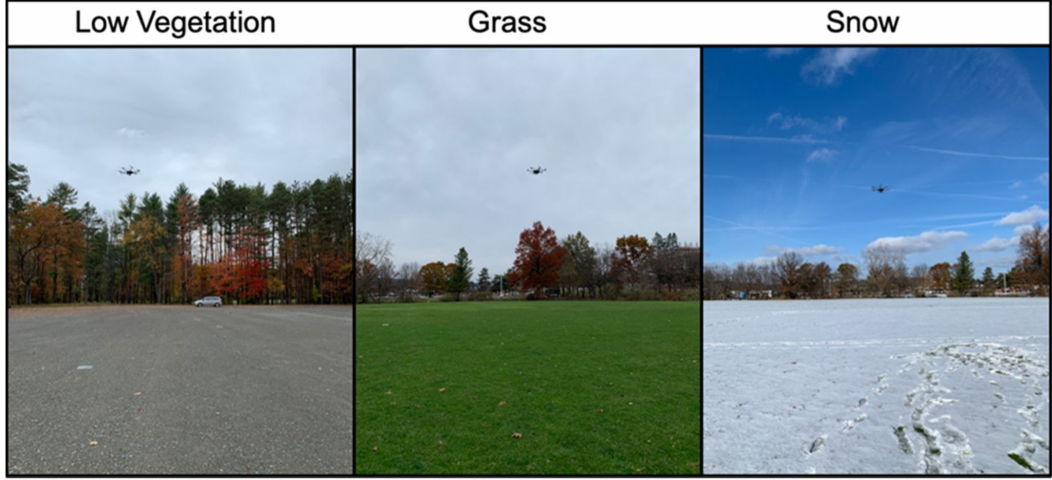
Figure 3. Environments for collected datasets. ( Left ) Chenango Valley State Park, low vegetation flights on 20 October 2019. ( Middle ) Binghamton University, grass field flights on 5 November 2019. ( Right ) Binghamton University snow flights on 13 November 2019 where half of the mines were covered by snow and half surface